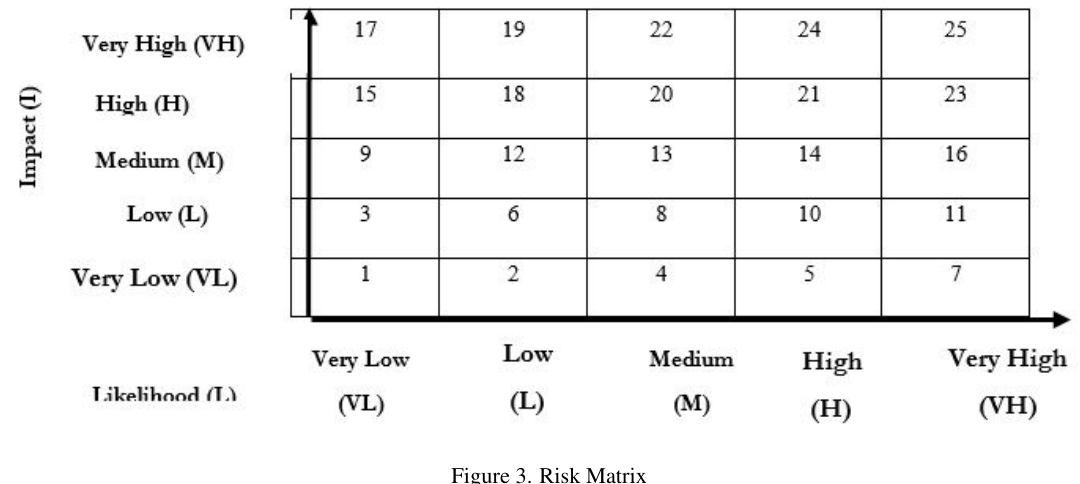
Figure 3. Risk Matrix